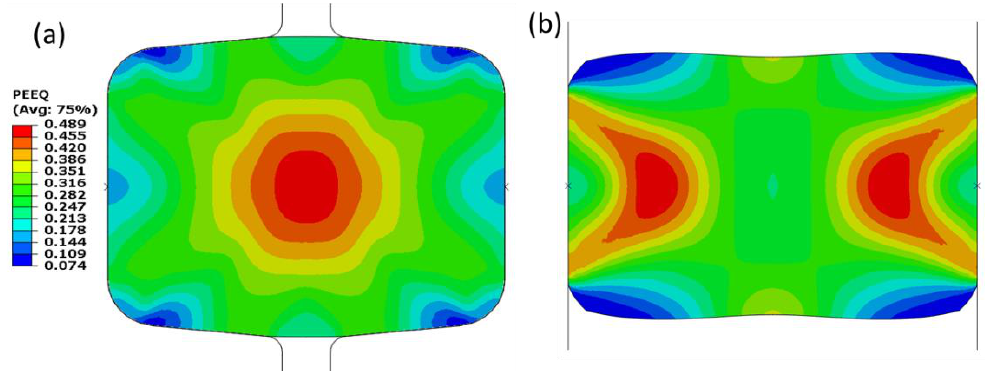
Figure 11. Von Mises stress distribution on the deformed strip after strip deformation by stand 14.